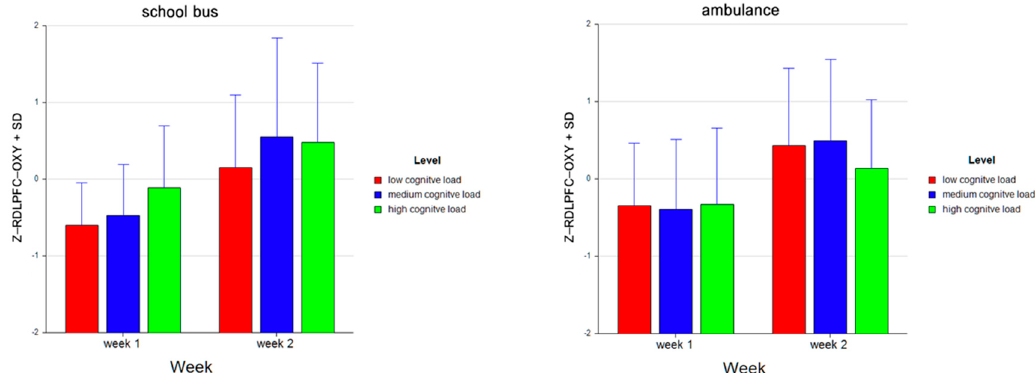
Figure 14. Bar charts represent average standardized z-scores for oxygenation for right dorsolateral prefrontal cortex (Z- RDLPFC-OXY) and standard deviation (SD) for low cognitive load, medium cognitive load, and high cognitive load tasks for experiment Week 1 and Week 2 (left) and School Bus and Ambulance problem scenarios (right).